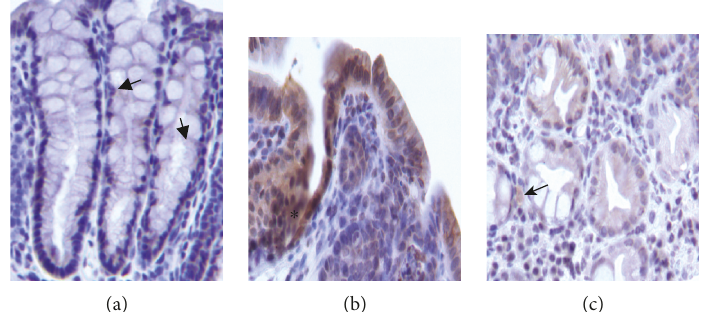
Figure 4: Representative micrographs of MIF detection by immunohistochemistry in WT mice. (a) Colonic epithelium with slight MIF immunostaining (arrows) from the control mice. (b) WT CRC mice showed hyperplastic and regenerative epithelium ( ∗ ) with strong MIF immunostaining. (c) Neoplastic well-di ff erentiated glands showed mild MIF immunostaining, while in fl ammatory cells such as macrophages (arrow) showed stronger immunoreactivity (400x all micrographs). Photographs are representative of three independent experiments, n = 3 mice per group, and samples were analyzed by a blinded